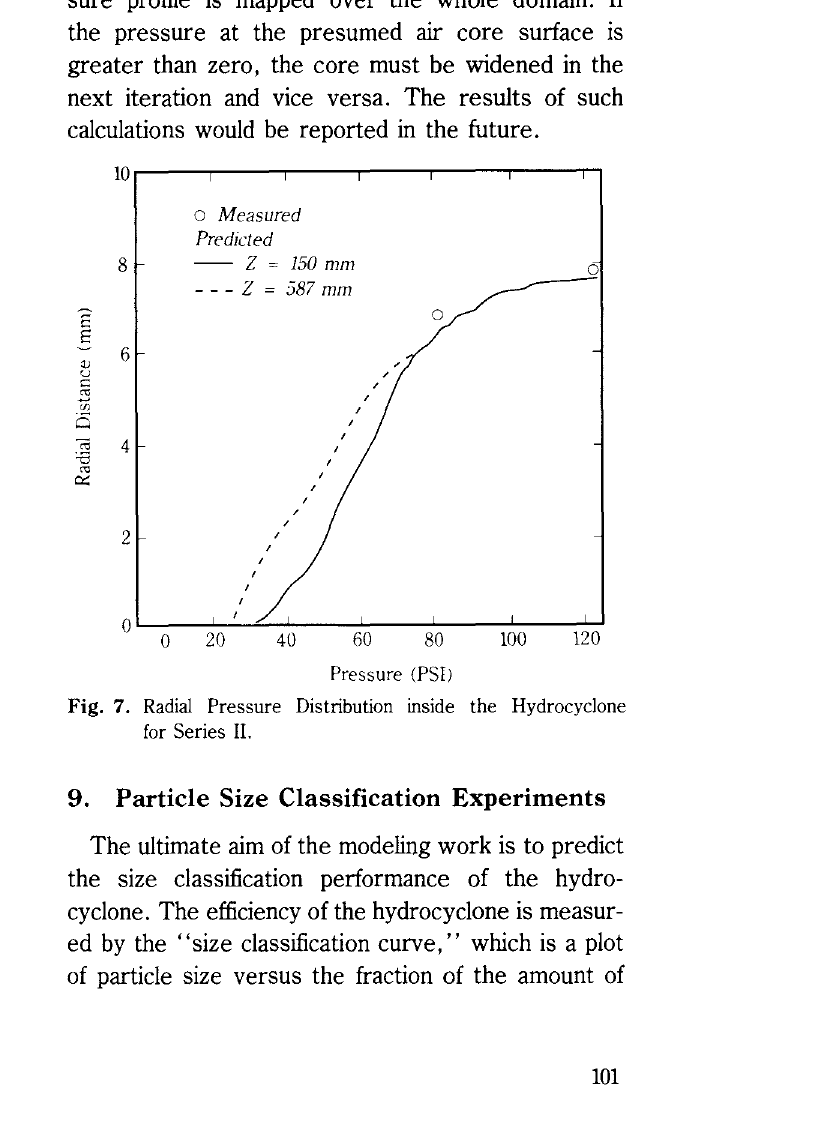
Fig. 6. Measured and Predicted Axial Velocities. 6(A) for Series I; 6(B) for Series II.